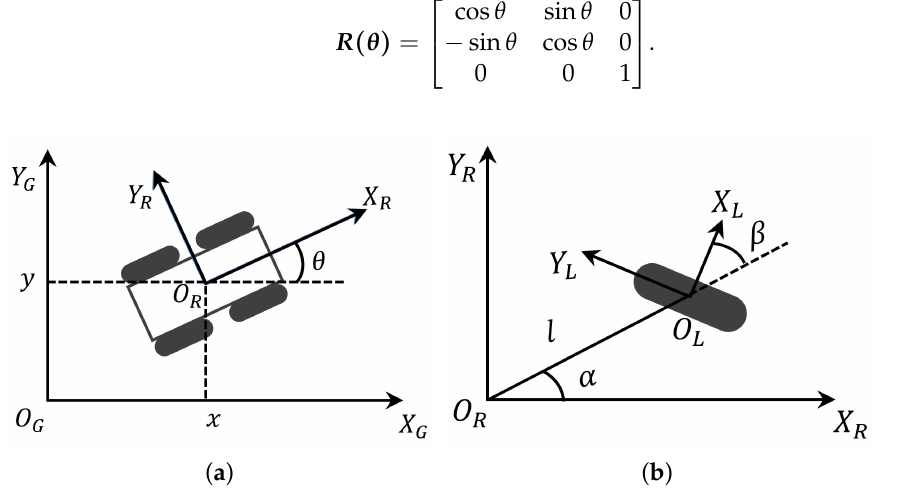
Figure 2. A wheeled mobile robot reference frame. ( a ) The pose of the robot in the global reference frame. ( b ) The pose of the wheel in the robot reference